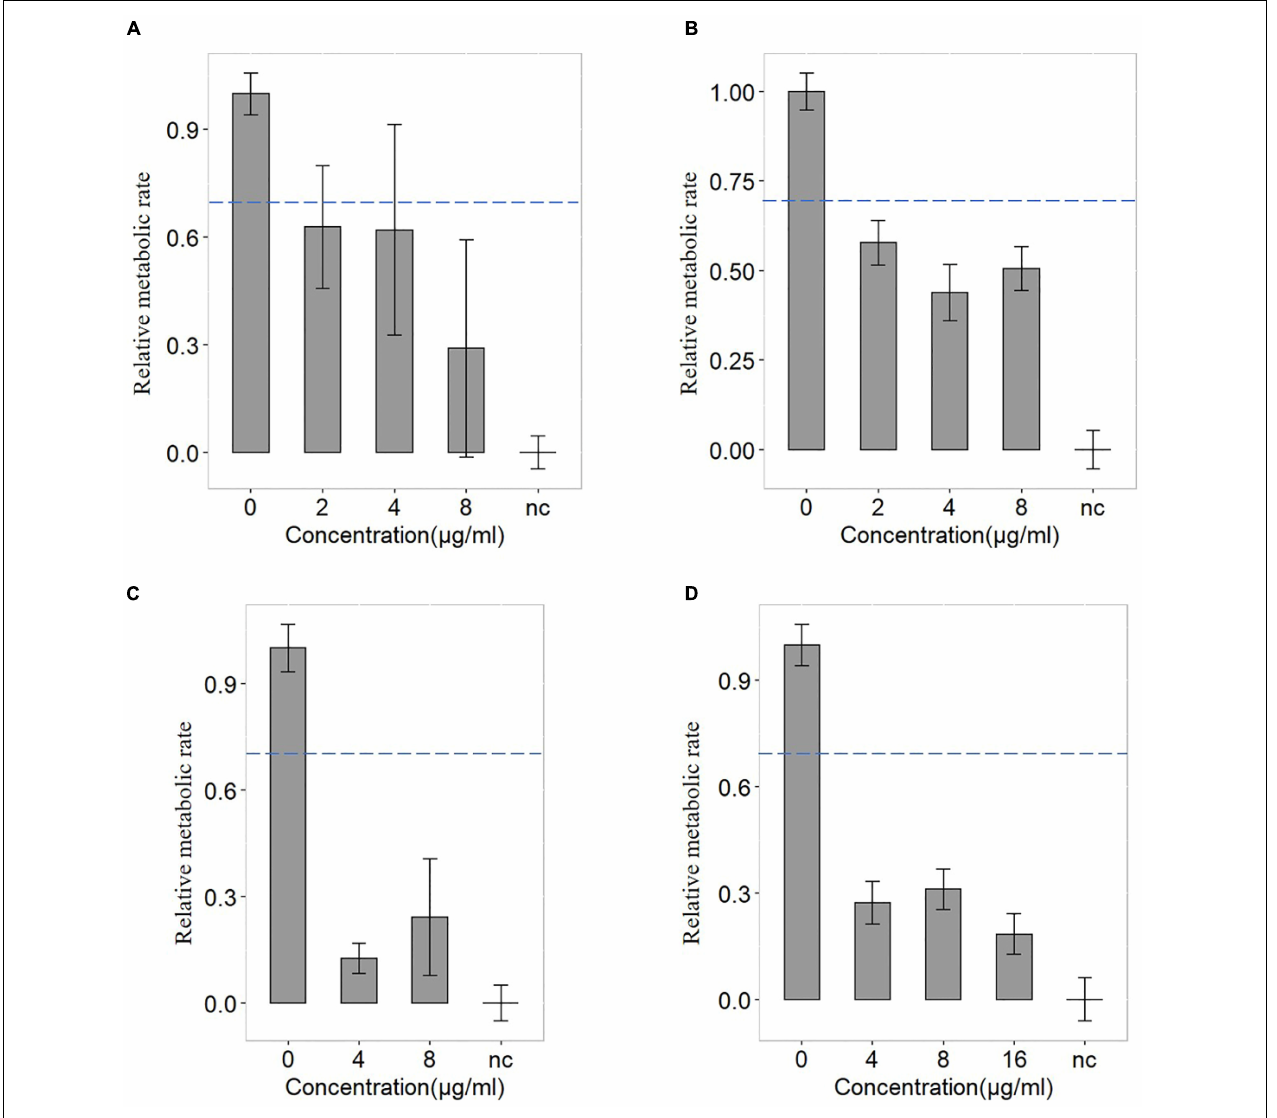
FIGURE 5 | The antimicrobial susceptibility of levofloxacin and minocycline of FMS-007. (A) the blood sample containing 10 6 CFU/mL treated with levofloxacin; (B) the blood sample containing 10 7 CFU/mL treated with levofloxacin; (C) the blood sample containing 10 6 CFU/mL treated with minocycline; and (D) the blood sample containing 10 7 CFU/mL treated with minocycline. The dotted lines indicated the cutoff value at 0.7 of the relative metabolic